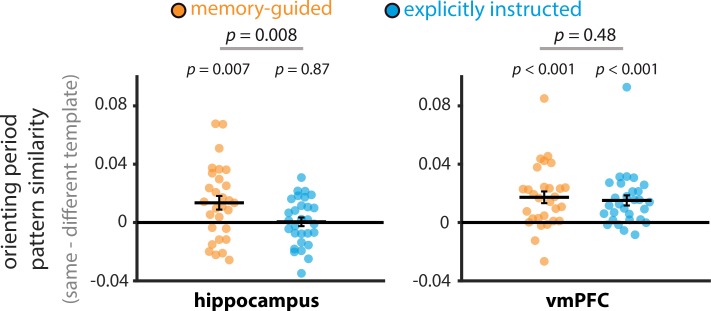
Representations of upcoming attentional states following ‘switch’ cue trials.The analysis approach here is the same as that in Figure 5, except that only orienting periods following ‘switch’ cues were included in this analysis. Pattern similarity values are shown as difference scores between the match-to-same-template correlation and the match-to-different-template correlation: More positive values indicate more evidence for the upcoming attentional state, and more negative values indicate more evidence for the other attentional state (i.e., the attentional state on the previous trial). In the hippocampus, orienting period activity patterns resembled the upcoming attentional state more than the other (previous trial’s) attentional state, but only in the memory-guided task. A direct comparison revealed that preparatory coding (representation of the upcoming attentional state) was significantly stronger for memory-guided vs. explicitly instructed attention in the hippocampus. In vmPFC, preparatory coding was observed for both the memory-guided and explicitly instructed tasks, and this preparation did not differ in strength. Circles and solid lines show individual and average pattern similarities, respectively. The results are shown as Pearson correlations, but statistical tests were performed after applying the Fisher transformation. The error bars indicate standard error of the mean for the within-participant difference in attentional state match (i.e., match to same template – match to different template) for each task.